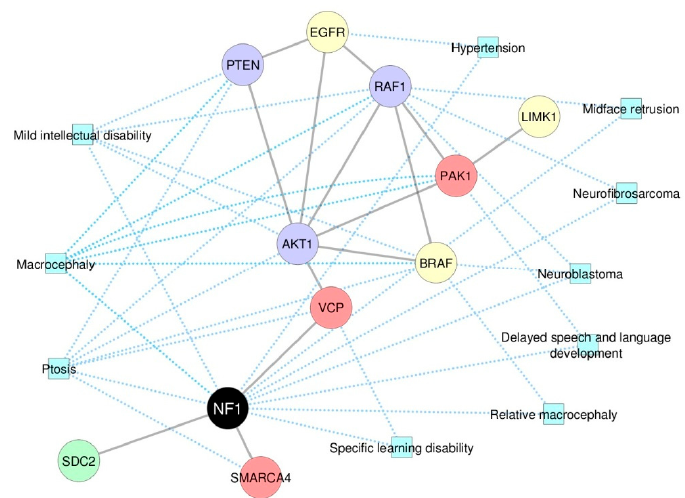
Figure 4. A complex network evaluation comprising the 10 candidate phenotype-modifier genes and the NF1 phenotypes they are related to. The ten candidate NF1 phenotype-modifier genes suggested by our analysis are represented with the NF1 phenotypes they are related. Yellow nodes: genes selected with the forward genetics strategy; red nodes: genes selected with the reverse genetics strategy; purple nodes: genes selected by forward and reverse genetics strategies; green node: gene selected by evaluating the differential gene expression in the complex network. Blue squares: phenotypes provided by the PhenomeScape tool, according to the associations presented in the HPO database.